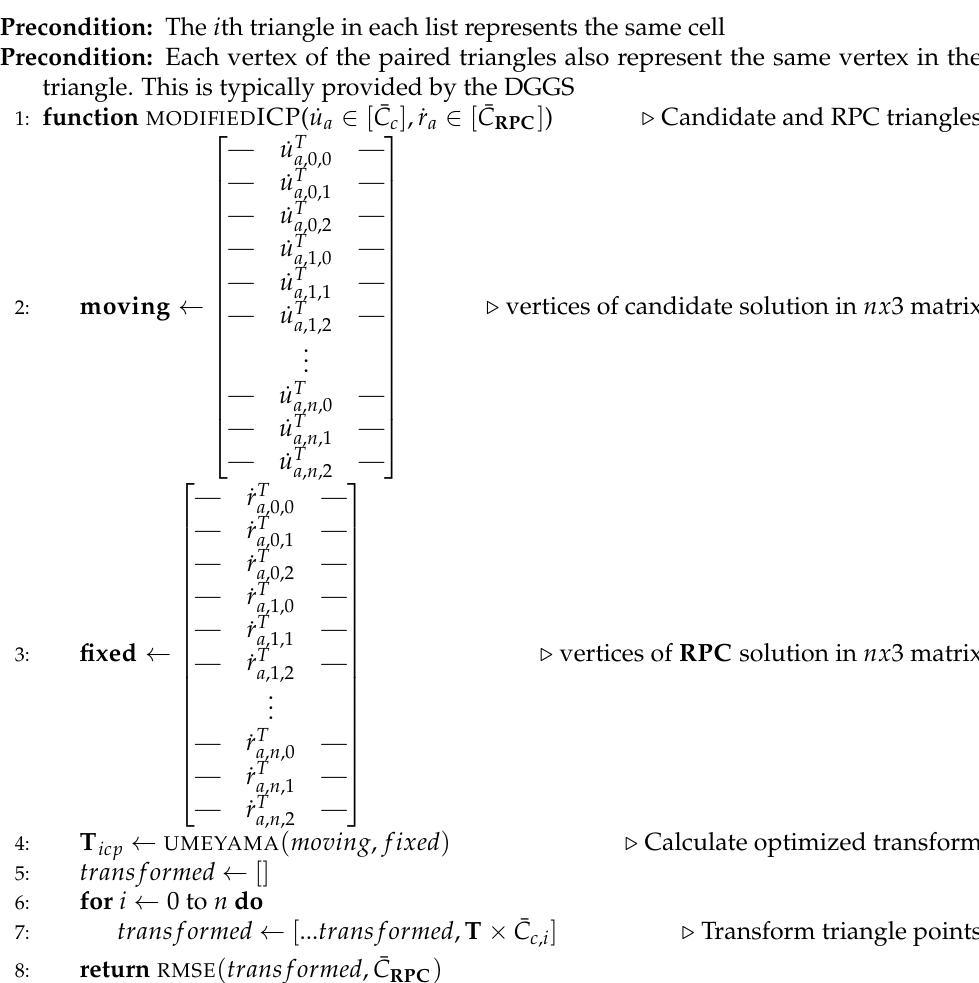
Algorithm 1 Assume the ordering of the incoming lists represents the correspondence, and find a single best transformation to bring the candidate cells as close to the RPC cells as possible. Measure the RMSE between points. This is the cost function/score for a given candidate